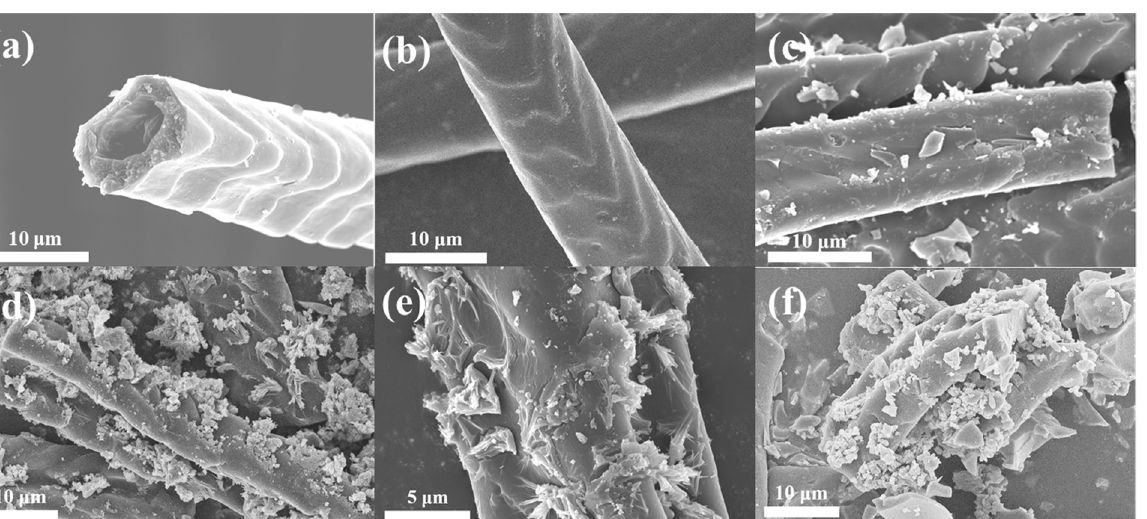
Figure 2. The standard working curve of MB solution.